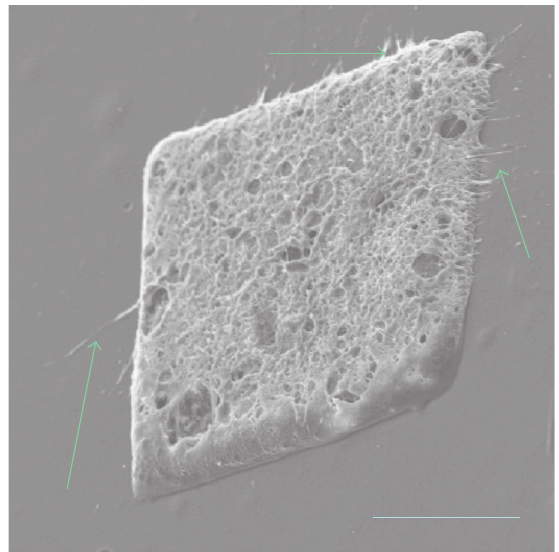
Figure 11: SEM image of collagen film surface after laser irradia- tion, ( F = 1 . 7J/cm 2 , 1 pulse, scale bar is 50 μ m). Green arrows show characteristic filaments formed due to a strong gradient of fluence at the edges.